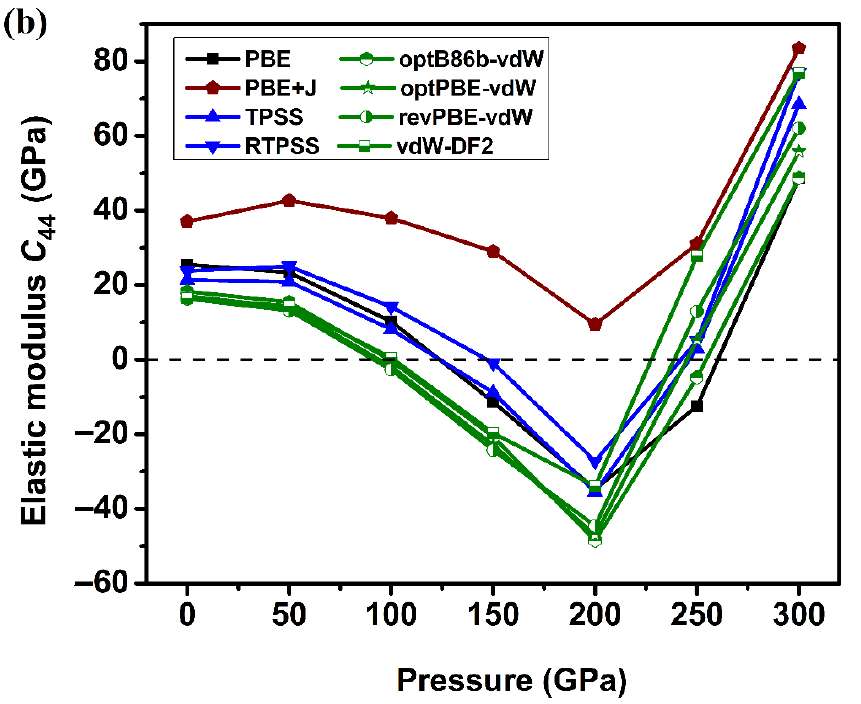
Figure 8. Calculated elastic moduli of BCC vanadium as a function of pressure by using different XC functionals and the PBE + J method (with J = 2 eV): ( a ) C 11 and C 12 , and ( b ) C 44 . (By the courtesy of Ref. [66]).